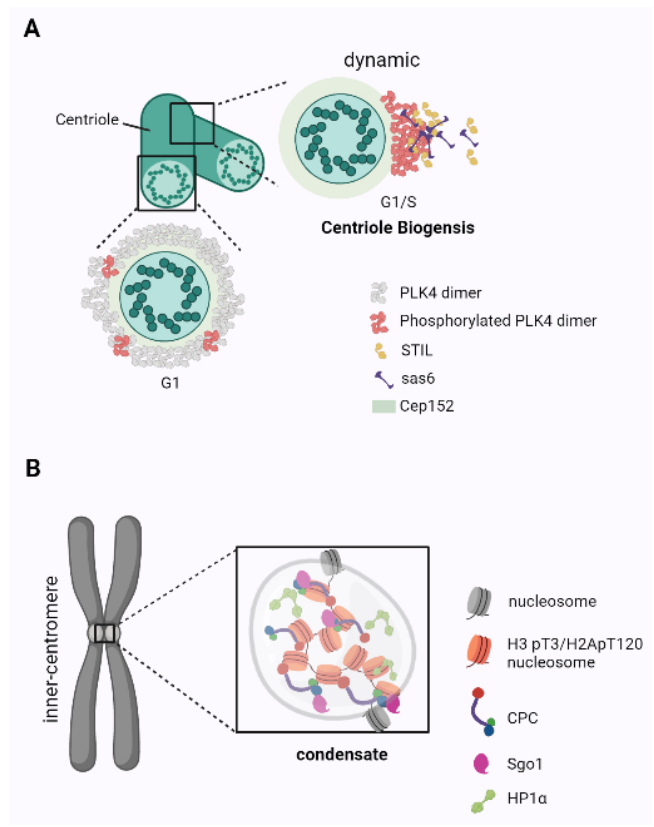
Figure 3. Regulation of mitotic chromosome behavior by phase separation. ( A ) Role of plk4 in centriole biogenesis. In G1, Plk4 exhibits a ring-like state around the Cep152 scaffold. During G1/S, Plk4 exhibits a dot state at the future procentriole assembly site. Phosphorylated PLK4 promotes centriole genesis by phase-separated recruitment of STIL and Sas6 to the assembly site. ( B ) Localization of the CPC to the inner-centromere driven by CPC phase separation. CPC is recruited to inner-centromeres by multivalent interactions with Histone H3pT3, Sgo1, and HP1 α